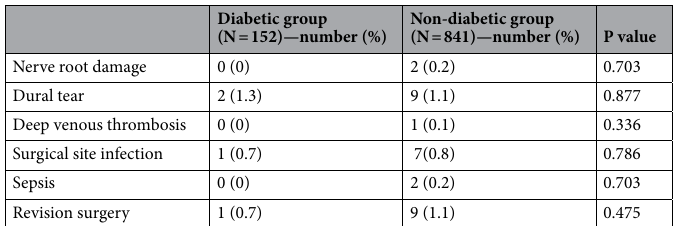
Diabetic group (N = 152)—number (%)